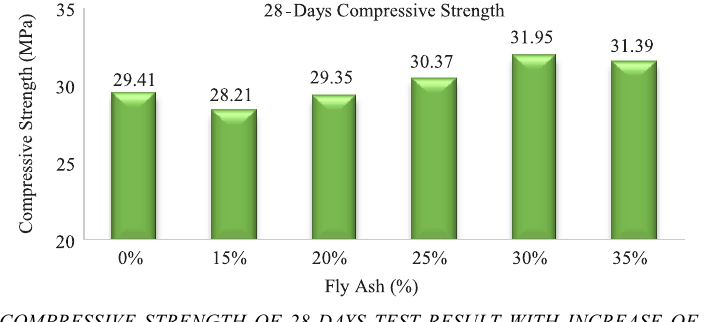
FIG. 2. COMPRESSIVE STRENGTH OF 28.5 HRS TEST RESULT WITH INCREASE OF FLY ASH